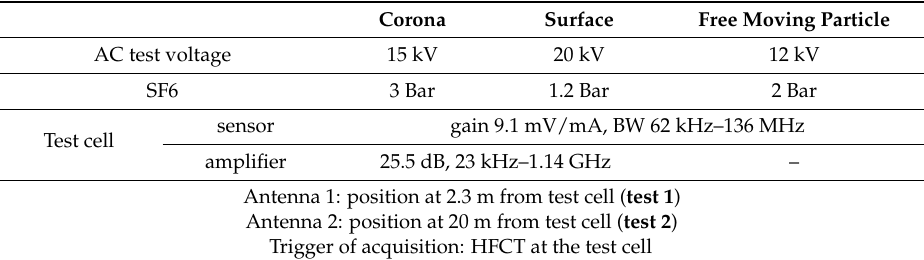
Table 3. Test parameters.